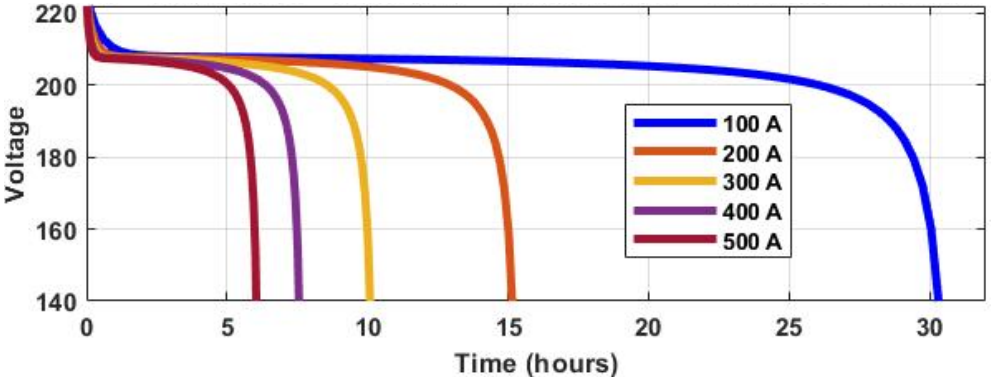
Figure 7. Battery discharge characteristics.